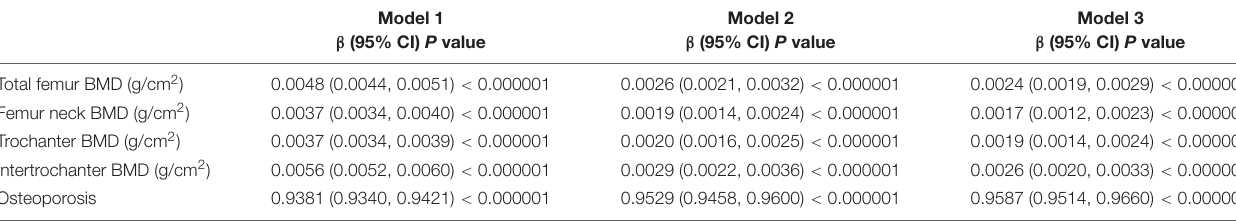
TABLE 2 | Associations of the GNRI with femur BMD and the risk of osteoporosis.